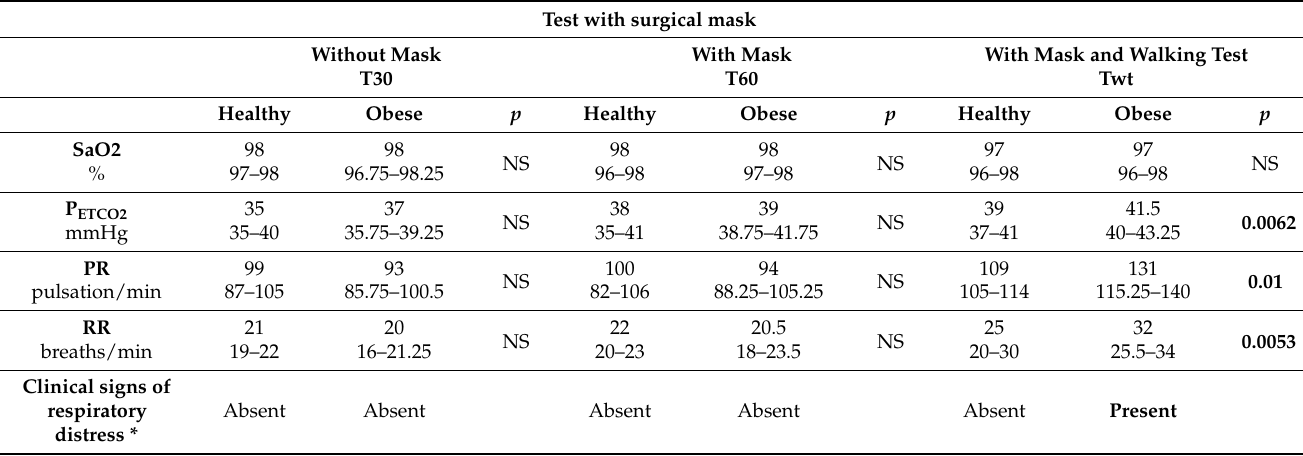
Table 5. Comparison between the group of healthy children and the group of overweight and obese children wearing an N95 mask. All data were expressed as median, 25th, and 75th quartile. Test with surgical